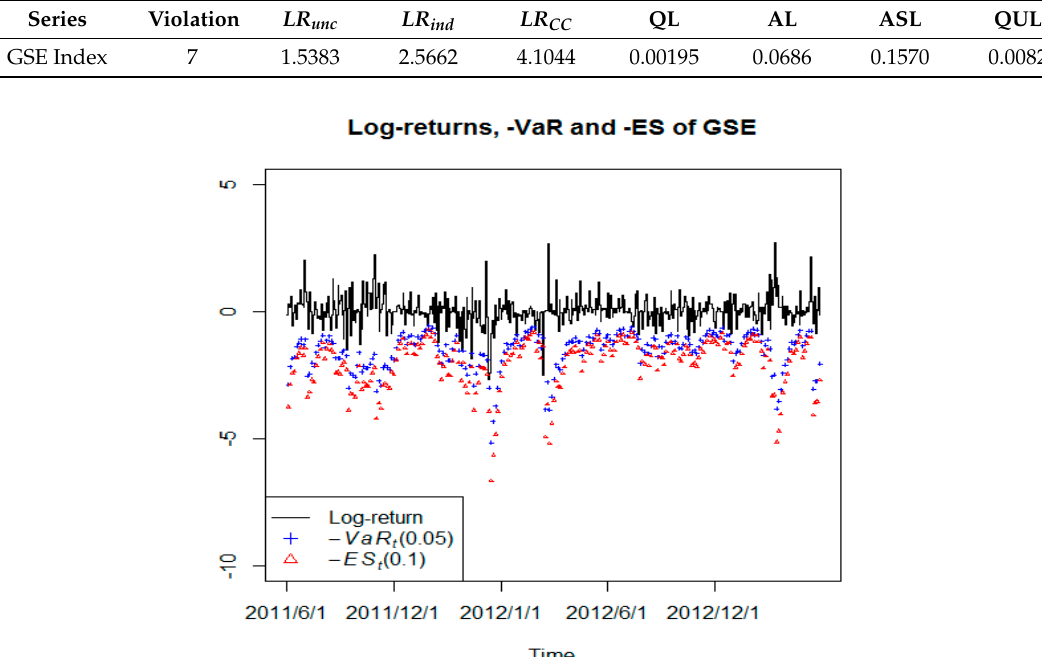
Figure 3. Plots of value-at-risk ( VaR ) forecasts and log returns for Ghana Stock Exchange (GSE) index where extreme value theory (EVT) model is not rejected.